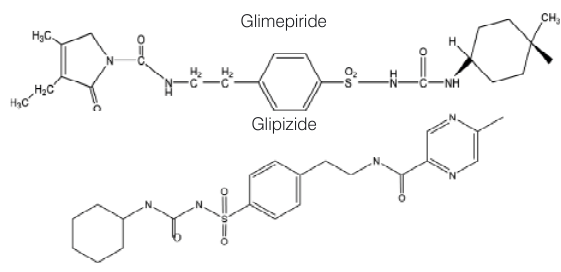
Figure 1. Structures of glimepiride and